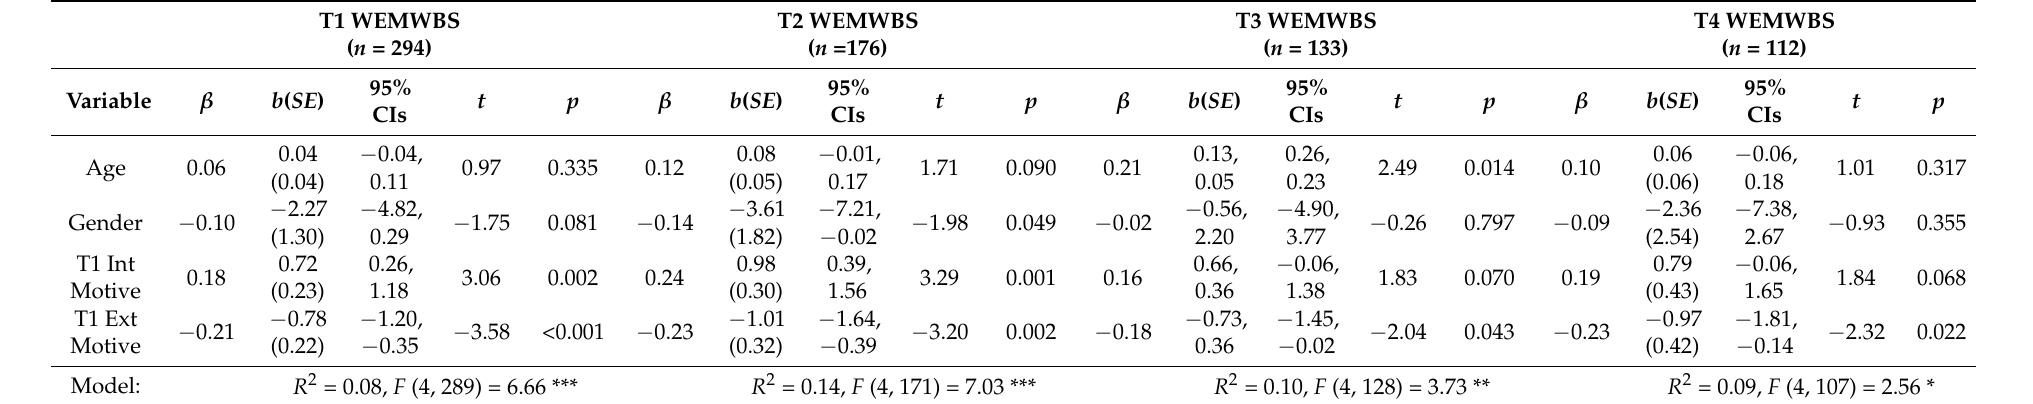
Table 4. Intrinsic and extrinsic motives as predictors of mental wellbeing from Time 1 to Time 4.